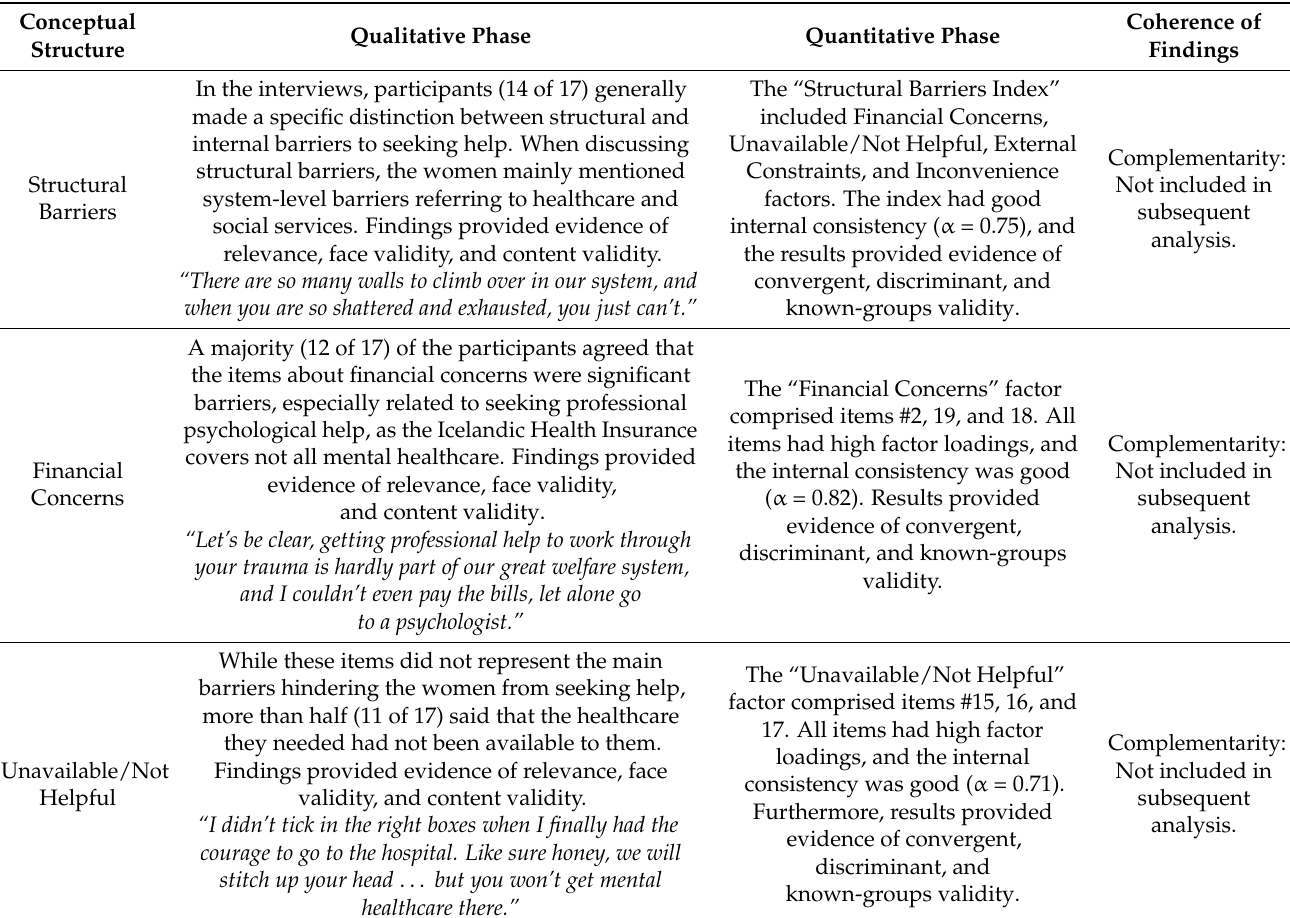
Table 2. Joint display of the coherence of findings for structural barriers to help